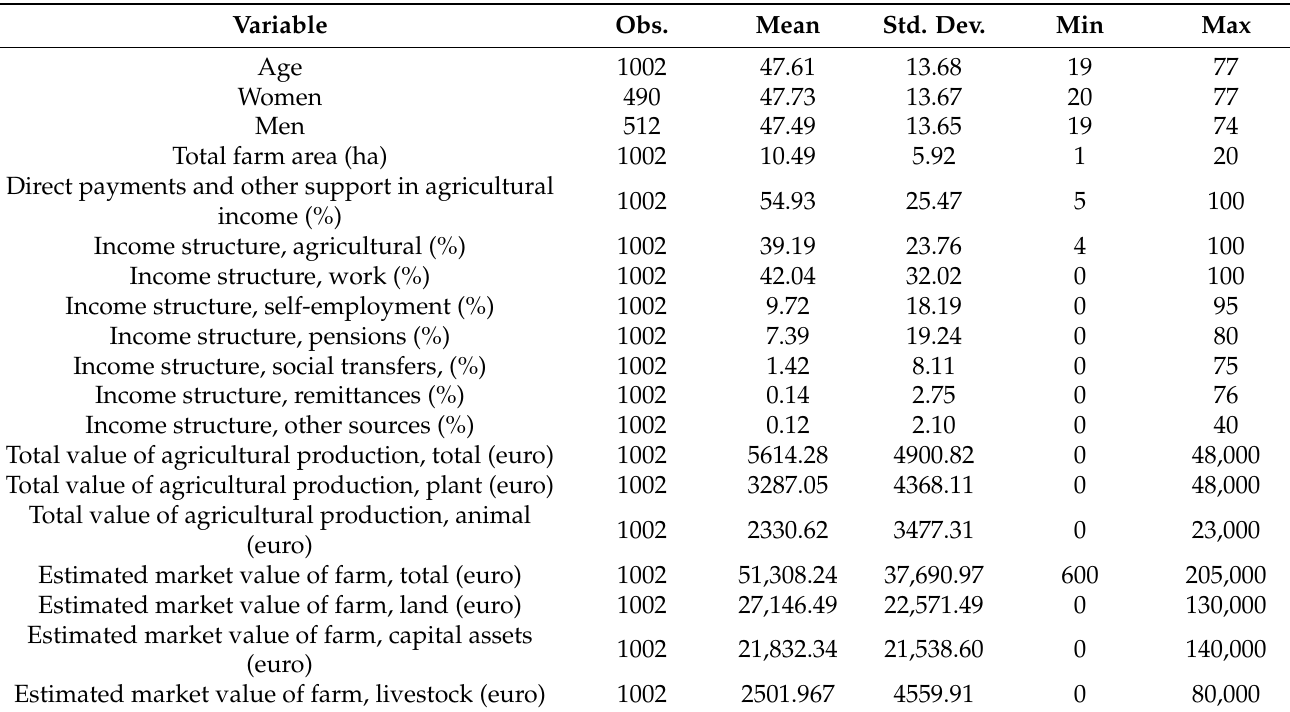
Table A1. Descriptive statistics of the main quantitative variables.